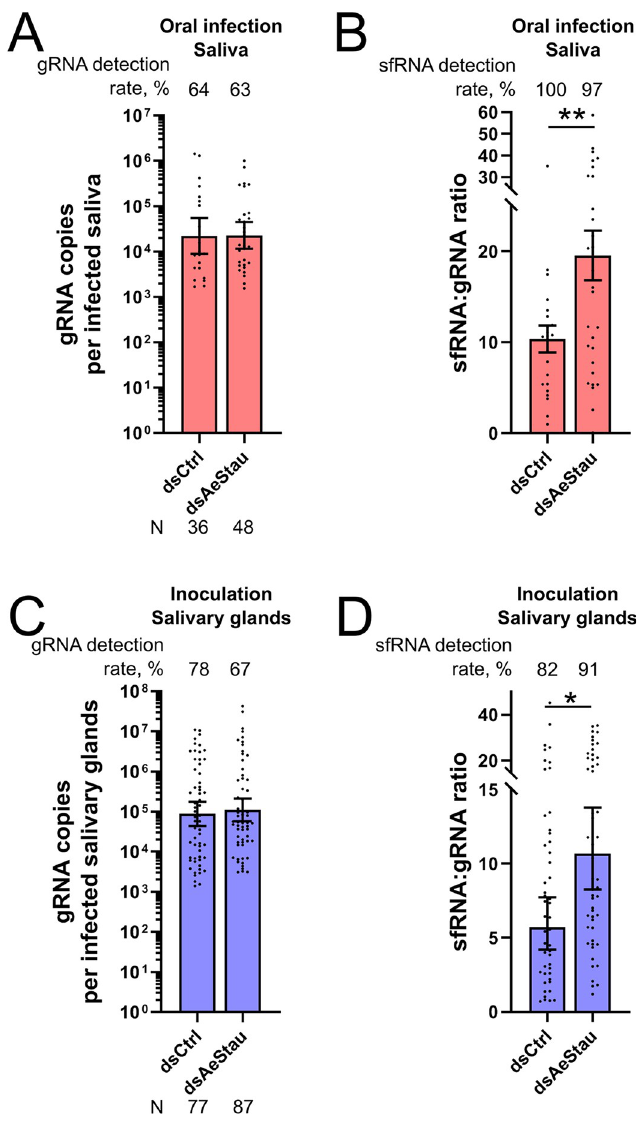
Fig 6. Effect of AeStaufen on sfRNA secretion in the saliva. (A-B) Effect of AeStaufen silencing ( dsAeStau ) on gRNA copies (A) and sfRNA:gRNA ratio (B) in saliva collected at 10 days post-oral infection. (C-D) Effect of AeStaufen silencing ( dsAeStau ) on gRNA copies (C) and sfRNA:gRNA ratio (D) in the salivary glands at 7 days post-inoculation. dsLacZ was injected as control. (A, C) Bars indicate geometric means ± 95% C.I. (B, D) Bars indicate means ± s.e.m. N, number of mosquitoes analyzed. � , p-value < 0.05; �� , p-value < 0.01 as determined by unpaired